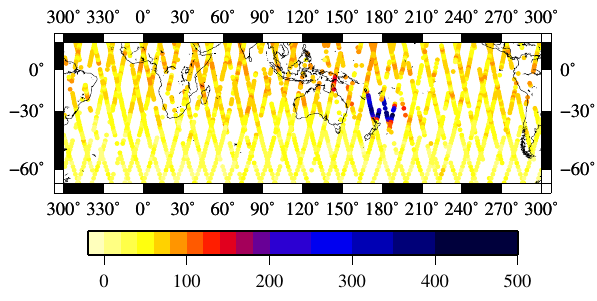
Fig. 1. MLS CO volume mixing ratio (in ppbv) at 100hPa on 12 and 13 February 2009. Each dot represents a single MLS data point. Both descending and ascending orbits are shown. Successive ascending (or descending) orbits are separated by 24 ◦ of longitude. The ascending orbit tracks for a given day are displaced by approx- imately 12 ◦ of longitude from those of the previous day. Values plotted as purple and blue are much larger than those usually seen at this altitude. Negative values can occur in places where the mix- ing ratio is small compared to the measurement